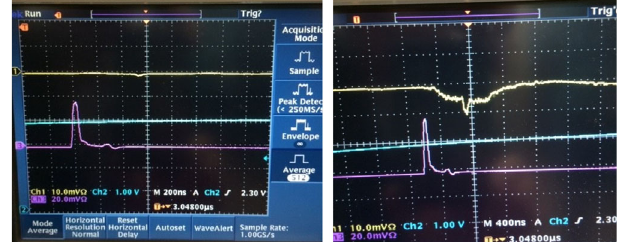
FIG. 4. An oscilloscope screen shot of the fluorescence detector signal. The left panel shows signals with the laser beam open but the ion beam blocked. The right panel shows signals with both beams open. The top trace is the PMT signal; the bottom trace is a photodiode signal for triggering. A weak laser-induced back- ground is seen in the left panel. The right panel shows the radiation background during the beam pulse and the fluorescence signal in the middle of the pulse.